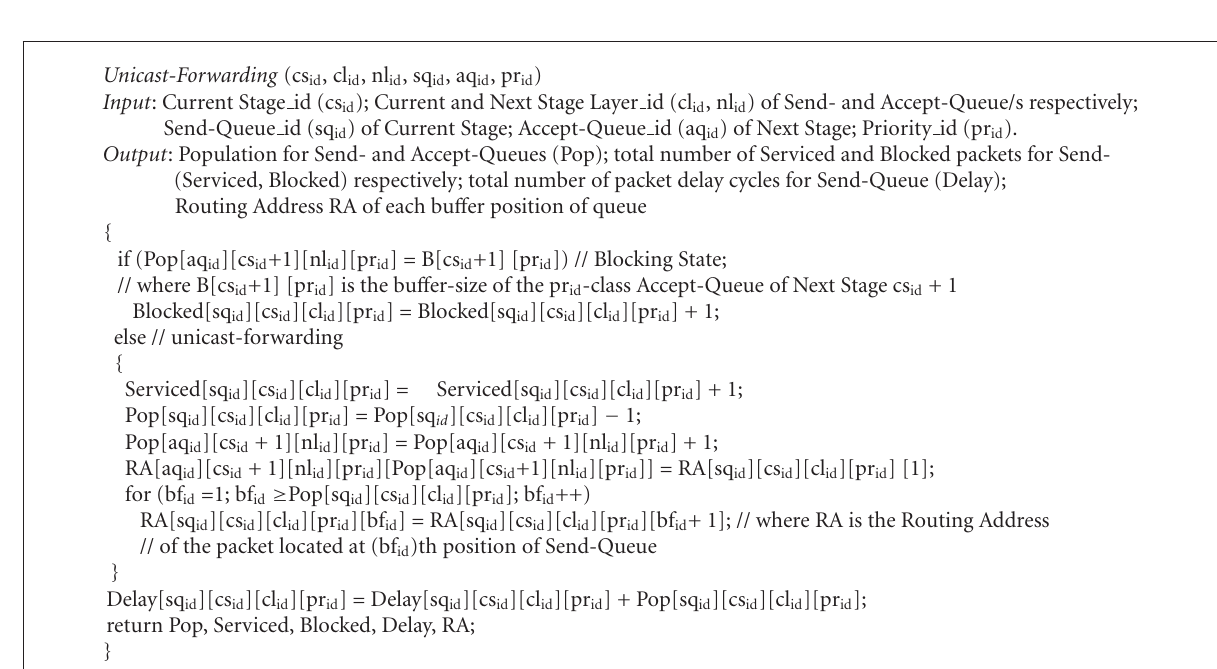
Algorithm 1: Queue-process for multilayered, multipriority MINs.